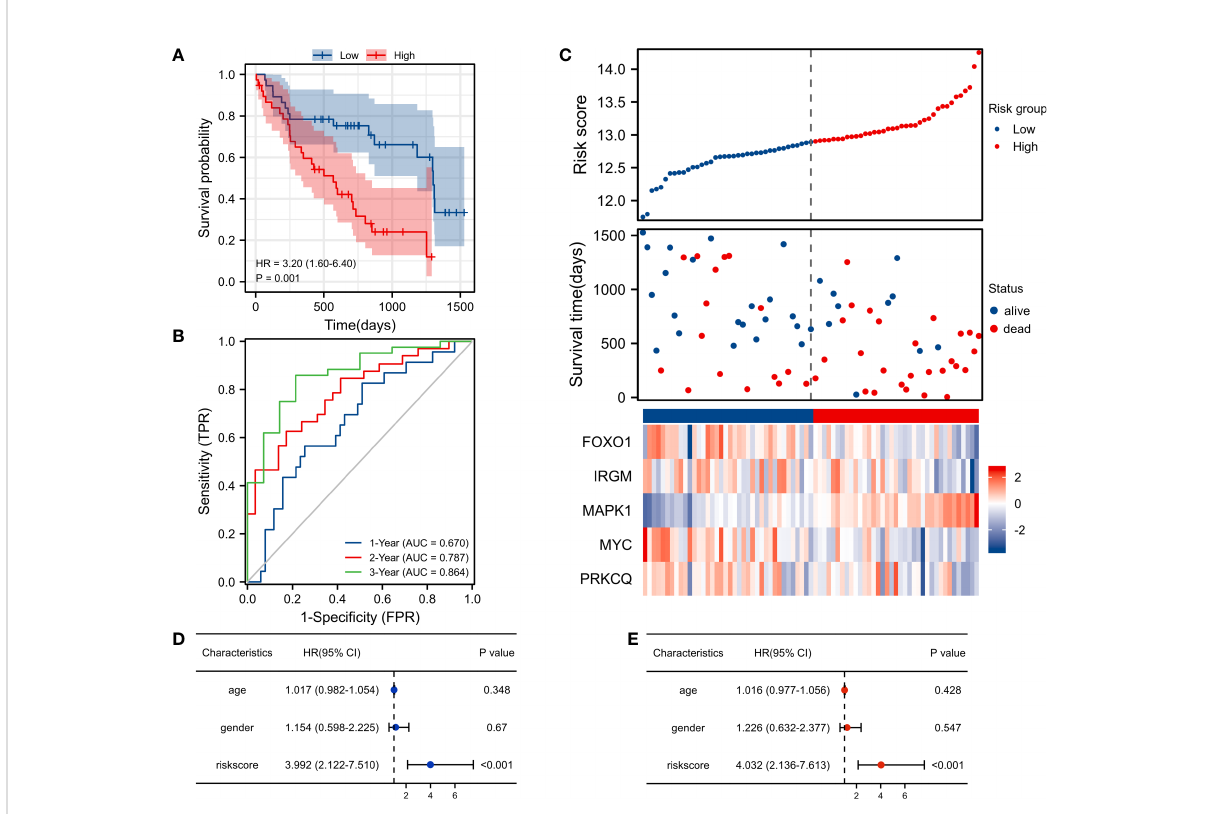
FIGURE 3 Risk score analysis of the autophagy-associated prognostic model in the GSE28042 training cohort. (A) Survival curve of high-risk score and low- risk score groups. (B) ROC curves evaluated the ef fi ciency for predicting 1-, 2-, and 3-year survival. (C) Risk plot distribution, survival status, and heatmap of fi ve genes expression. (D) Univariate cox analysis of riskscore in GSE28042. (E) Multivariate cox analysis of riskscore in